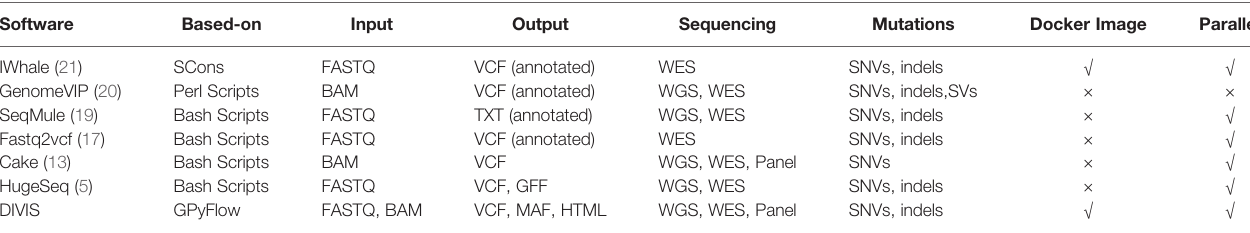
TABLE 1 | Pipeline software of somatic mutations